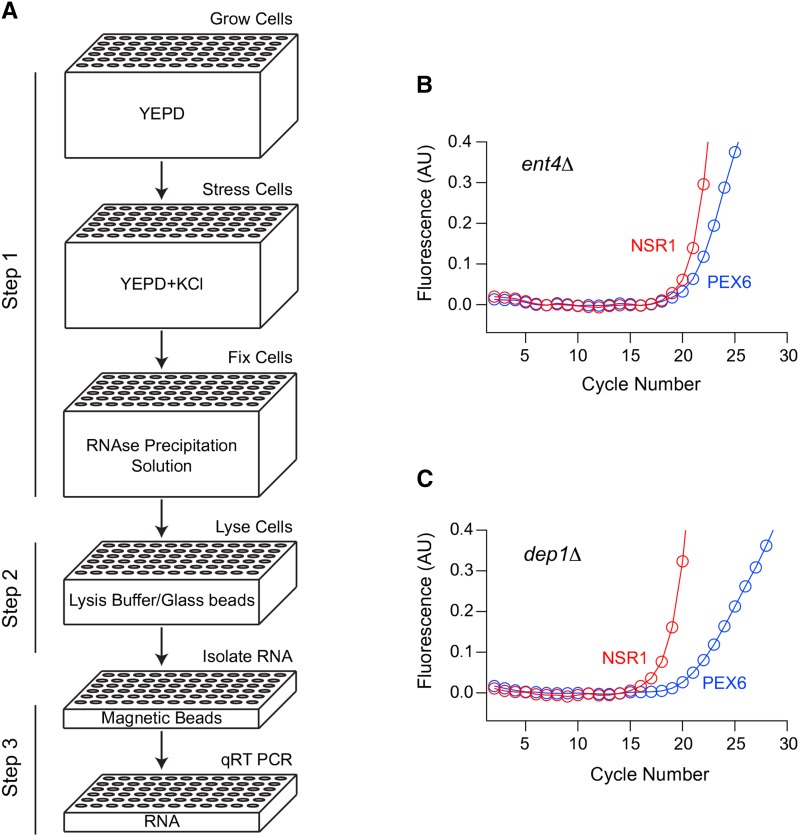
Automated analysis of gene expression in yeast. (A) Strains from the Yeast Knock Out (YKO) collection were inoculated into a 96-well plate containing YEPD medium, and grown to an OD600 of 0.6 in a Biomek FX robot with an integrated Liconic shaking incubator. The plates were then brought onto the deck of the robot, treated with 0.4 M KCl, rapamycin, or mock stress, and returned to the incubator. After 20 min, the plates were retrieved again but this time treated with 4 M NH4SO4 (pH 4.6) to block all further RNA synthesis and degradation. Cells were then lysed by bead-beating, and the RNA purified from each well using magnetic beads, and loaded into a PCR plate for analysis. (B and C) Duplex quantitative PCR was used to measure the expression of the Ribi gene NSR1 (FAM labeled probe; red), and the housekeeping gene PEX6 (JOE labeled probe; blue) in each well of the plate from the library. In most strains (such as ent4Δ from plate 1), NSR1 and PEX6 expression levels were similar. However, we also found numerous strains (such as dep1Δ from plate 1) with higher levels of NSR1 than PEX6. Quantitation of these data using standard procedures (see Materials and Methods) then led to a NSR1/PEX6 ratio for each sample (log2 = –2.8 for dep1Δ and –0.1 for ent4Δ).